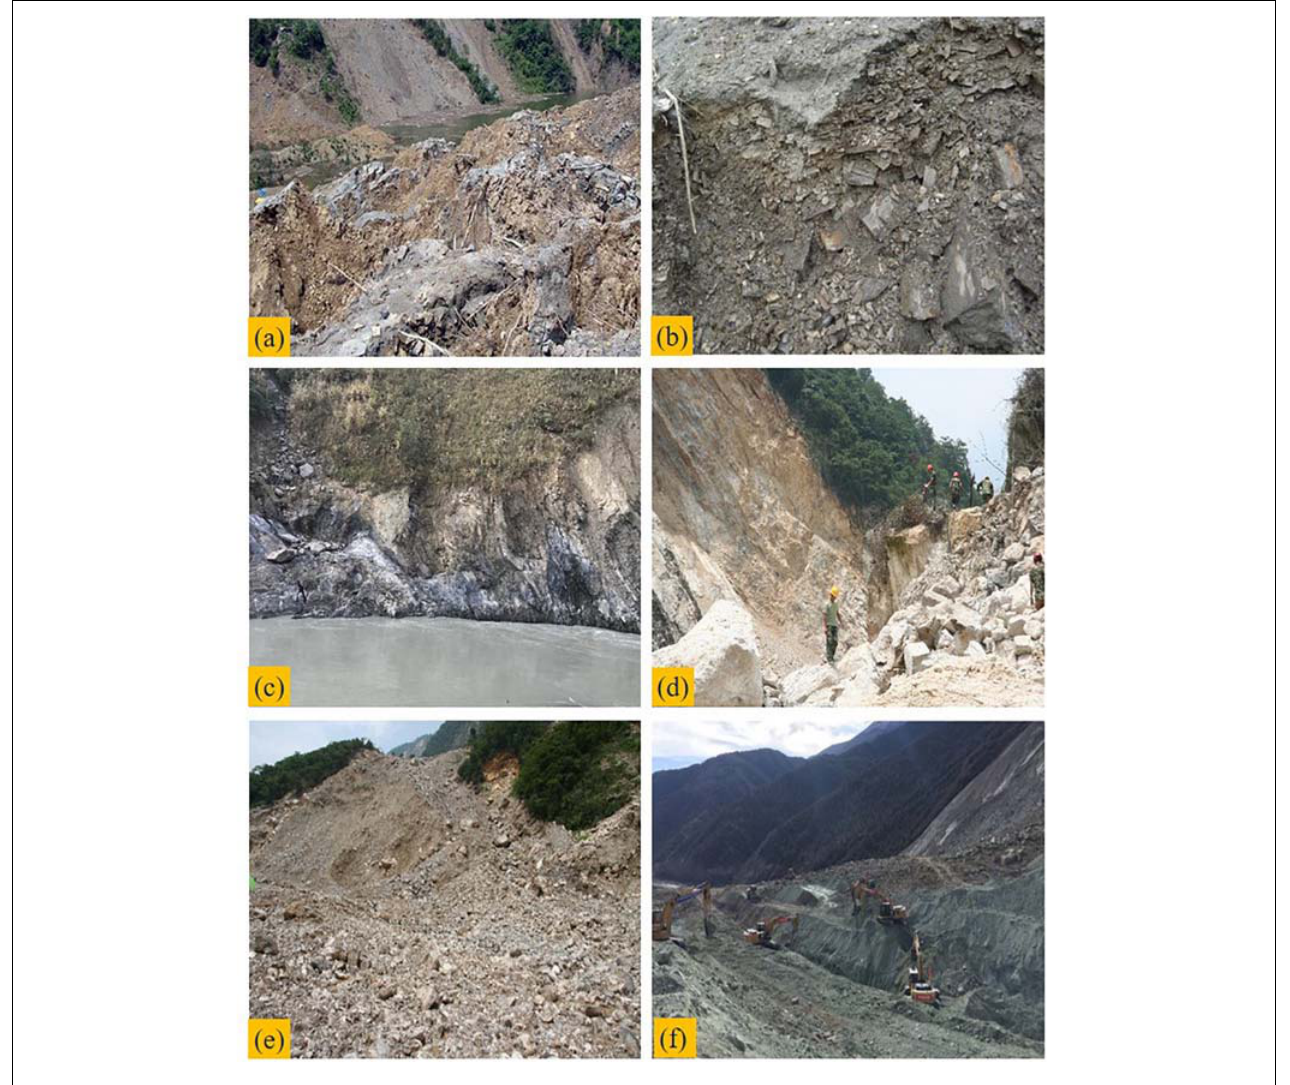
FIGURE 4 | Grain size distribution of landslide dams: (a) gravelly soil; (b) cataclasite; (c) bedrock; (d) boulder; (e) soil and rock fragment; (f) sand and gravel.